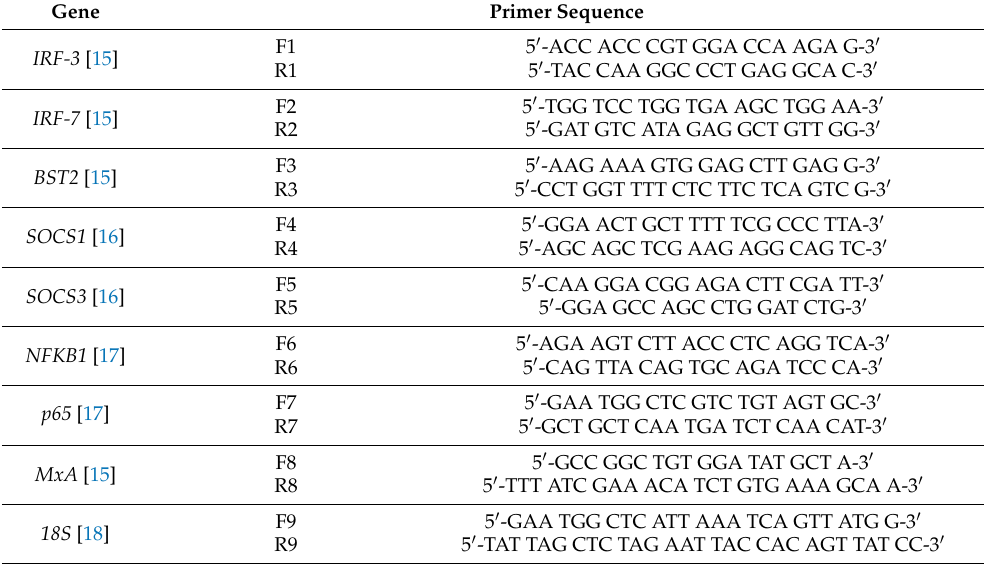
Table 1. Primers used for real-time